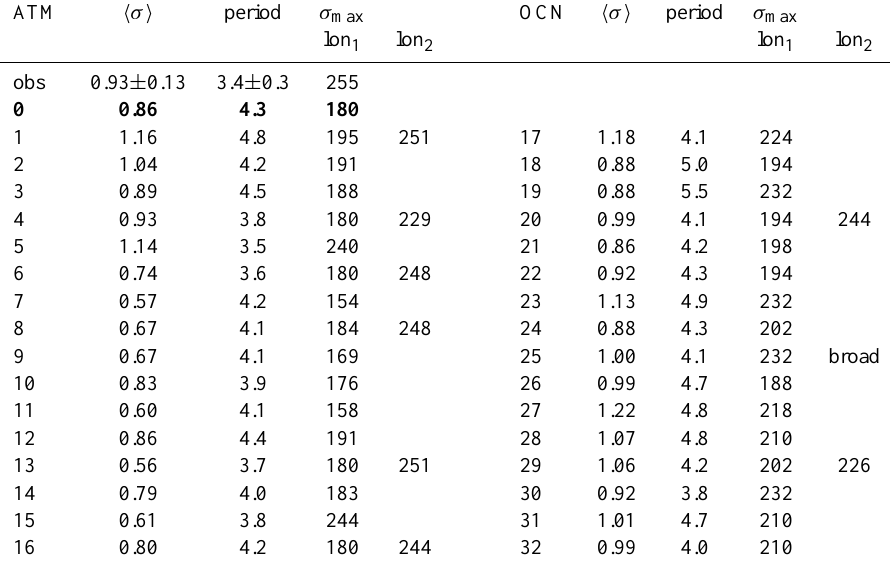
Table 1. ENSO characteristics in the perturbed parameter ensemble. The top row shows the characteristics from observations (obs) (Reynolds v2 SST). The error margin for the period is obtained from NCDC ERSST v3b data. In bold the STAM member. The amplitude h σ i is defined as the mean SST-standard deviation σ [ ◦ C] over 5 ◦ S–5 ◦ N, 160 ◦ E–100 ◦ W. The mean period [years] is calculated from the timeseries of the average σ over this box. For the ENSO pattern the longitude at which the σ reaches a maximum σ max in this box is given, together with a second maximum if this is approximately equally high. The term “broad” describes the describes the fact that the amplitude has no clear maximum but is zonally rather broad. Members 1–16 are part of the ATM-ensemble, members 17–32 describe the OCN-ensemble. Sampling errors in computing model values are of a similar order of magnitude as those computed for the observations. h σ